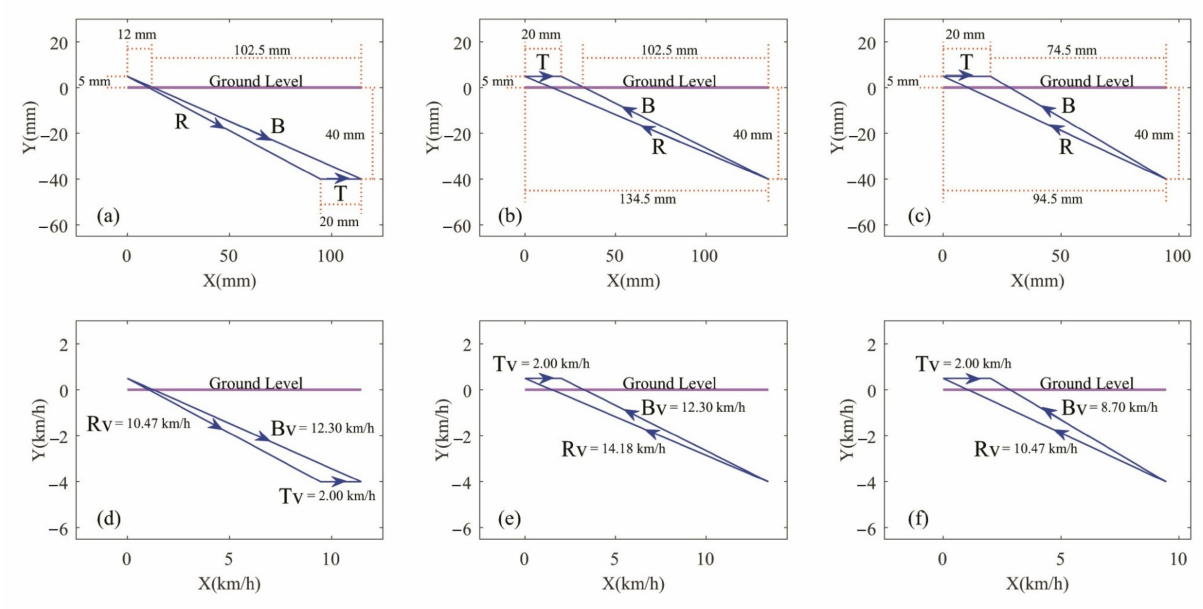
Figure 2. ( a – c ) Displacement vector diagrams; ( d – f ) velocity vector diagrams for motion of tractor ( T ) and weeding blade ( R , B ).